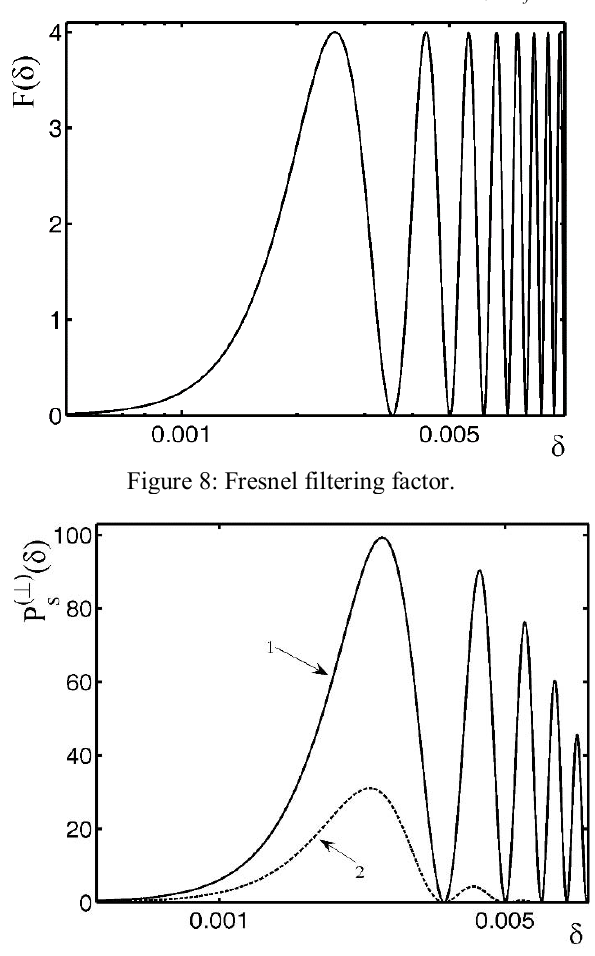
Figure 9: The power spectrum of the phase fluctuations versus parameter for the ordinary and extraordinary waves.